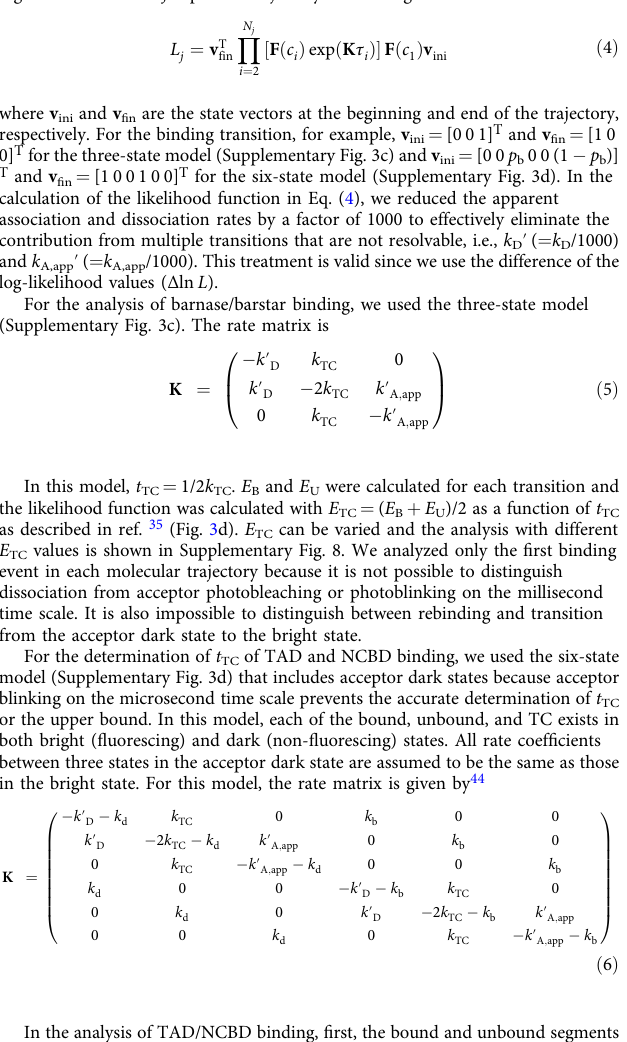
and t TC together (Fig. 3e, lower block of Supplementary Table 2), all six parameters ( E B , E U , k b , p b , E TC , and t TC ) were determined simultaneously by maximizing ln L ( t TC